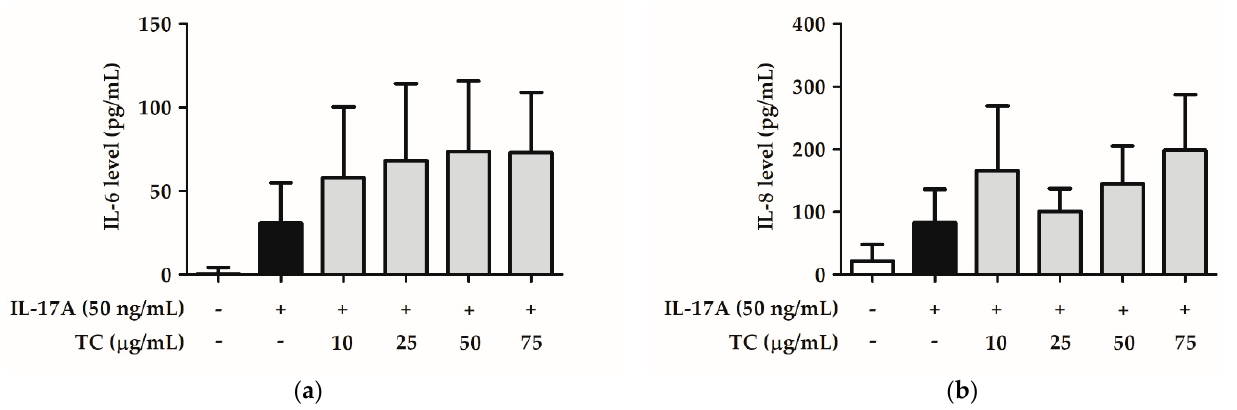
Figure 11. Effect of TC on IL-6 and IL-8 levels in IL-17A-treated human keratinocytes. ( a ) IL-6 level. and ( b ) IL-8 level. TC did not significantly reduce IL-17A-induced IL-6 and IL-8 levels in human keratinocytes.